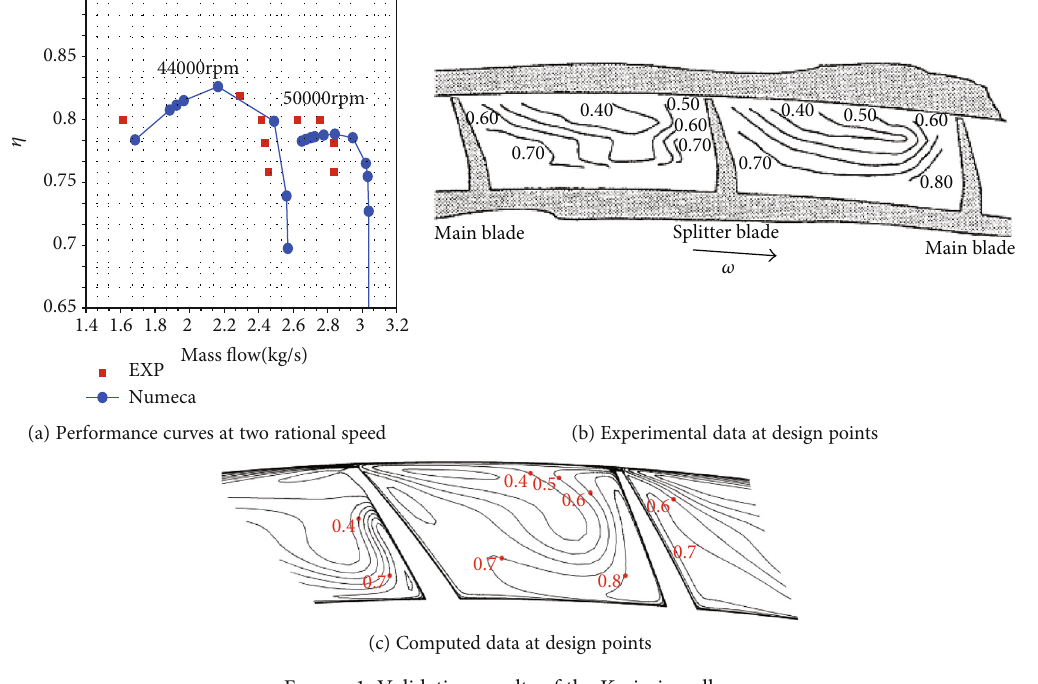
Figure 1: Validation results of the Krain